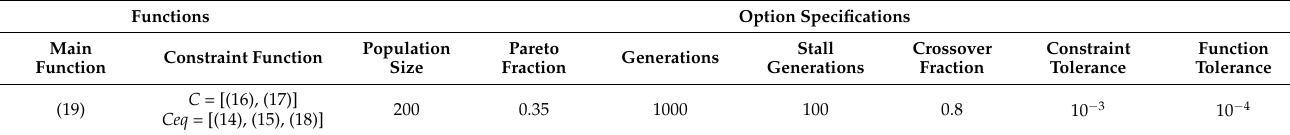
Table 3. The function parameters of the multi-objective genetic algorithm.